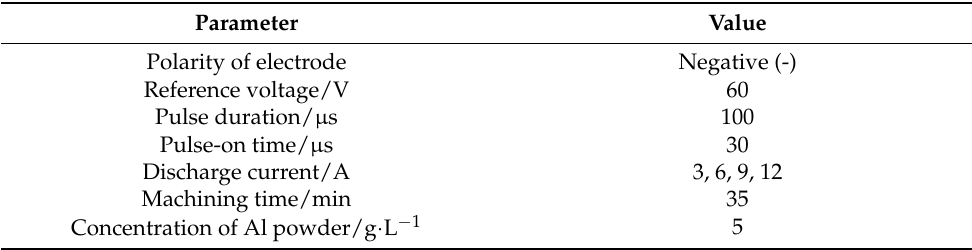
Figure 1. Schematic model of one-step fabrication of iron aluminide containing hydrophobic modified layers. Table 2. EDA experimental